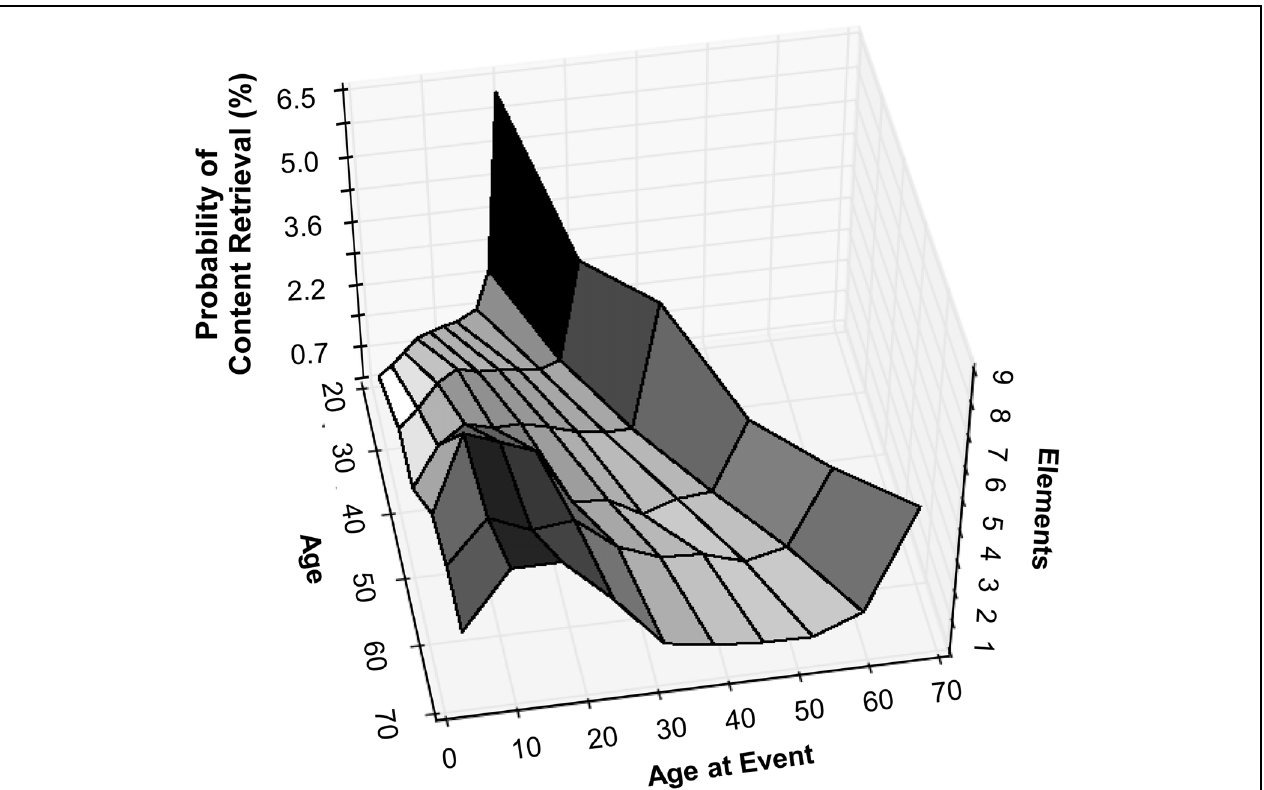
FIGURE 5 | Estimated distribution of retrieved content across age groups and life periods. Content measures within each temporal bin for each age group were normalized to their applicable retrieval probability. In particular, the number of elements per life period was computed for each of the six age